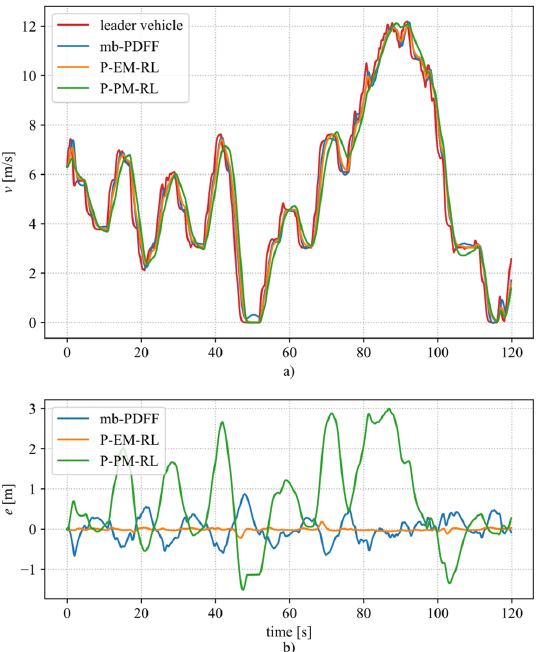
Figure 5. Velocity v of the leader vehicle, as well as the follower vehicle ( a ). The velocity of the latter was created by mb-PDFF, P-EM-RL, and P-PM-RL; the respective distance errors e = e 2, k are shown in ( b ).